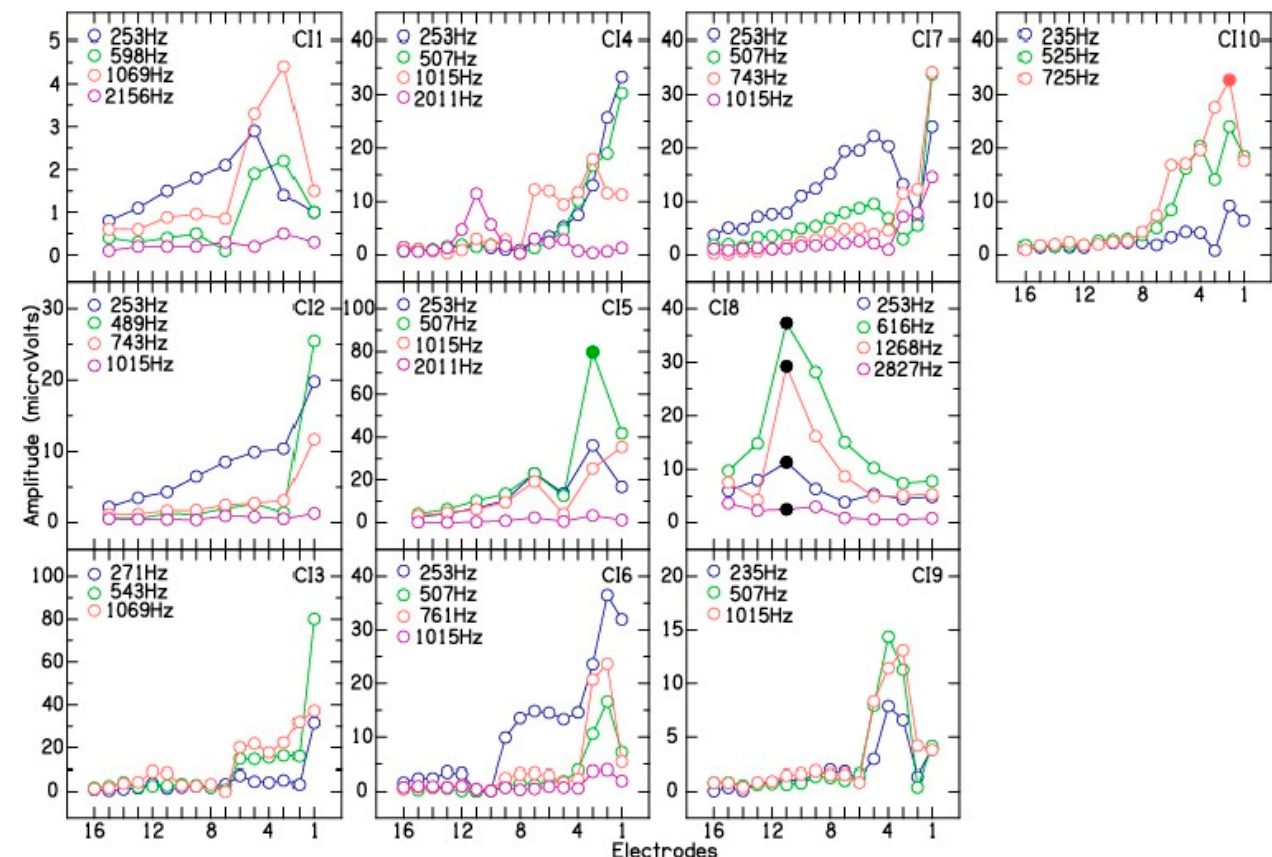
Figure 3. Intraoperative multi-frequency electrodes scan for the ten cochlear implant patients. The abscissa shows electrodes and the ordinate shows CM amplitude (µV). For patient CI8, black filled circles show correlated drops in CM amplitude for the four test frequencies. For patients CI5 (507 Hz) and CI10 (725 Hz), filled circles show phase reversal near electrode 2.